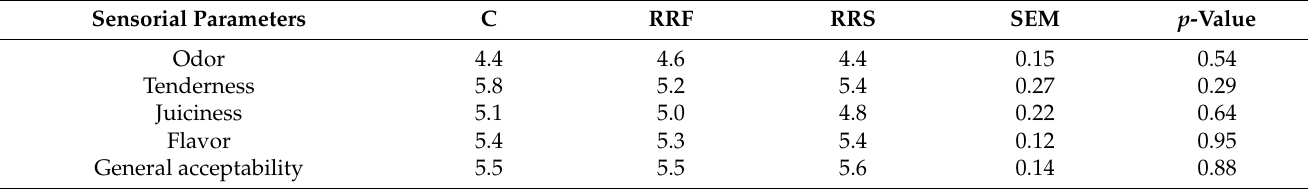
Table 6. Effect of rosemary residue intake on the sensory attributes of Barbarine lamb meat. Sensorial